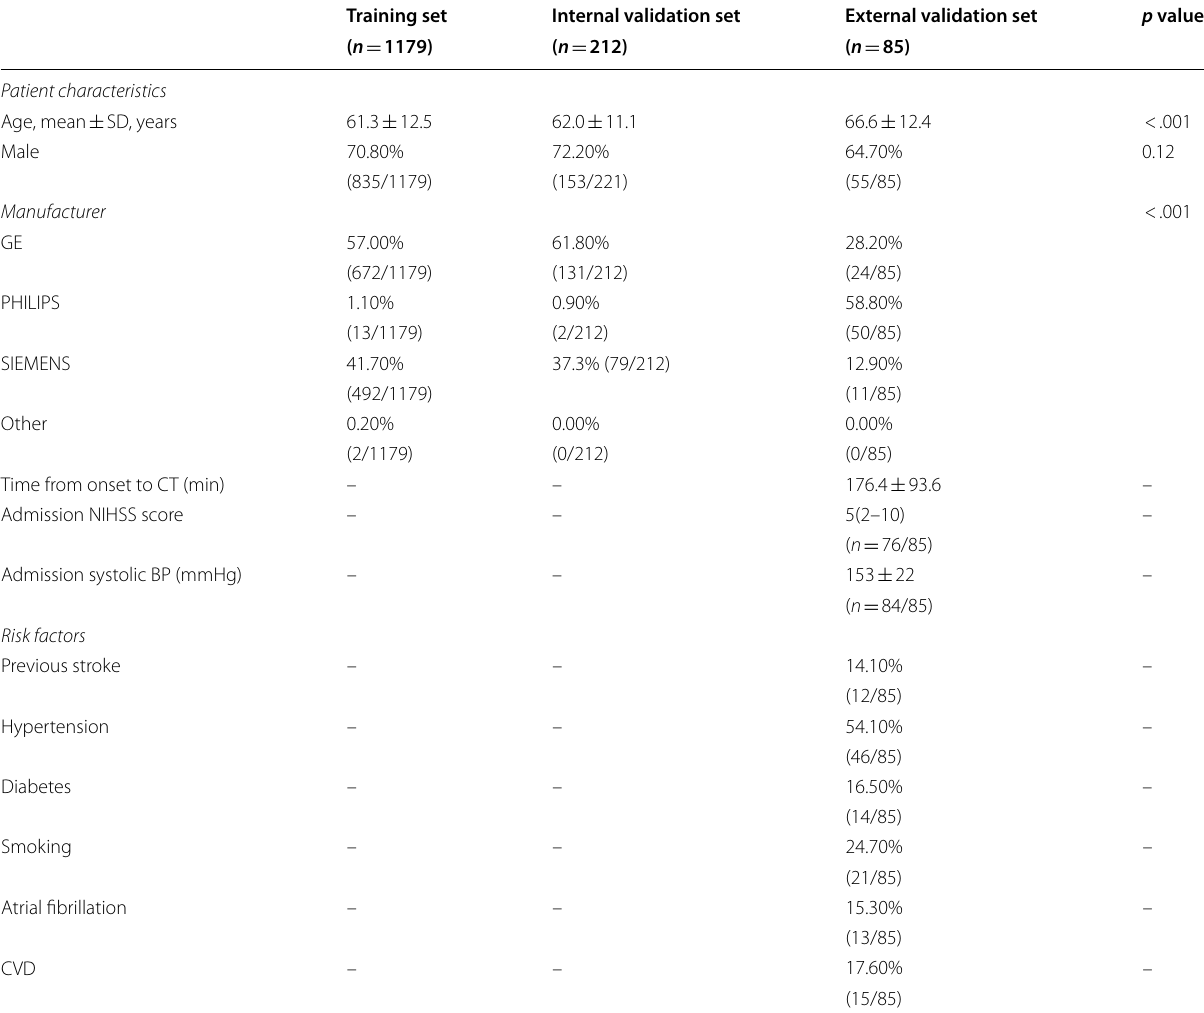
Table 1 Baseline demographic and clinical